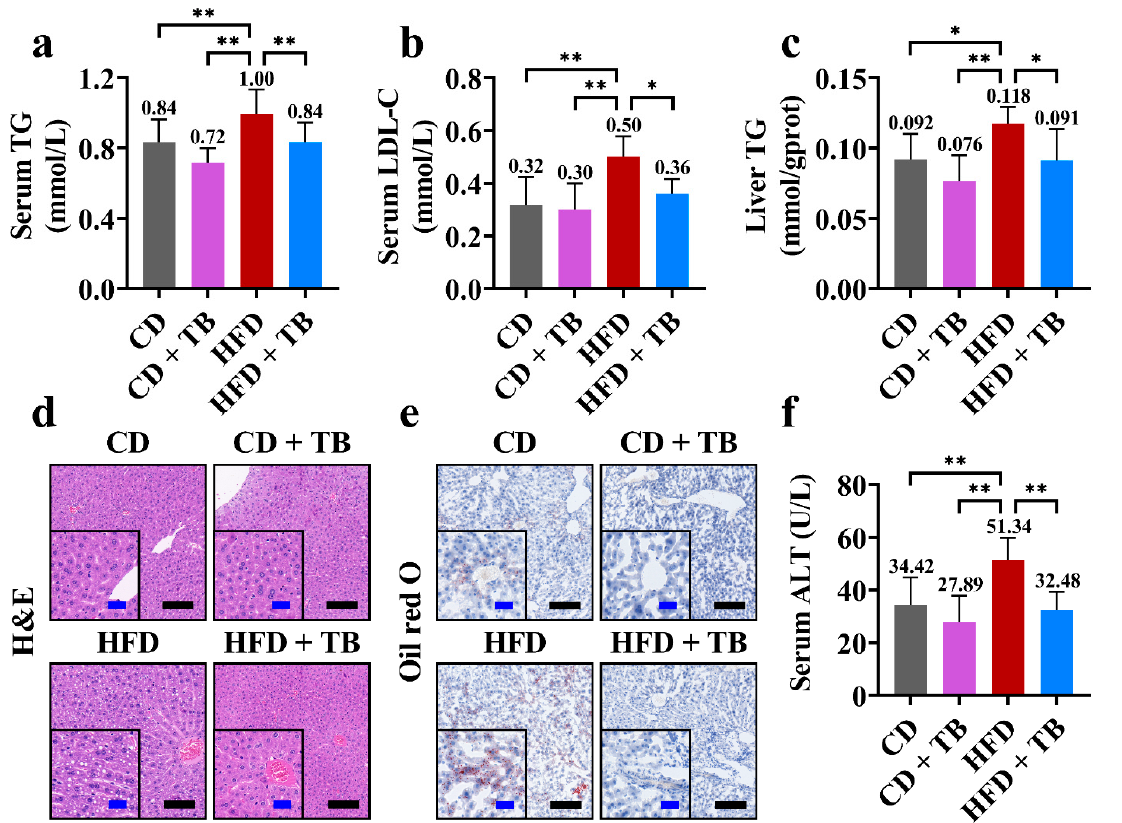
Figure 3. The effects of TB on lipid metabolism and hepatoprotection. ( a ) The serum level of TG. ( b ) The serum level of LDL-C. ( c ) The hepatic level of TG. ( d ) The hepatic H&E staining (black scale bar = 200 µ m and blue scale bar = 50 µ m). ( e ) The hepatic Oil red O staining (black scale bar = 200 μ m and blue scale bar = 50 μ m). ( f ) The serum level of ALT. * p -value < 0.05, ** p -value < 0.01. Abbreviation: ALT, alanine aminotransferase; CD, control diet; H&E, hematoxylin and eosin; HFD, high-fat diet; LDL-C, low-density lipoprotein cholesterol; TB, theabrownin, TG, triglyceride.